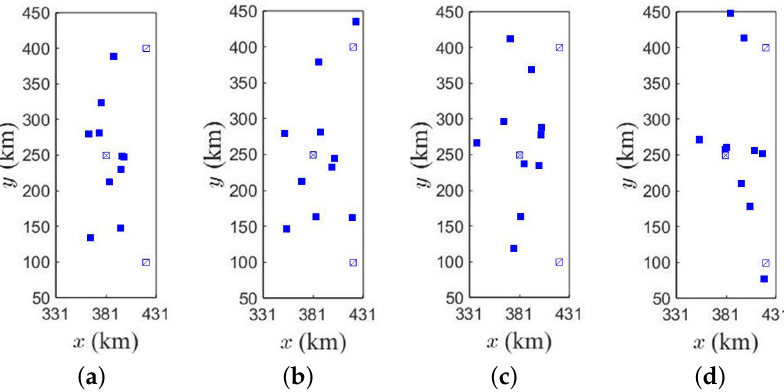
Figure 19. Optimal deployment plan of defense stations against pincer attack formation, with kill probability set to 1, based on ( a ) ζ 1 ; ( b ) ζ 2 ; ( c ) ζ 3 ; ( d ) ζ 4 , square with cross: major post, square with slash: minor post, blue square: defense